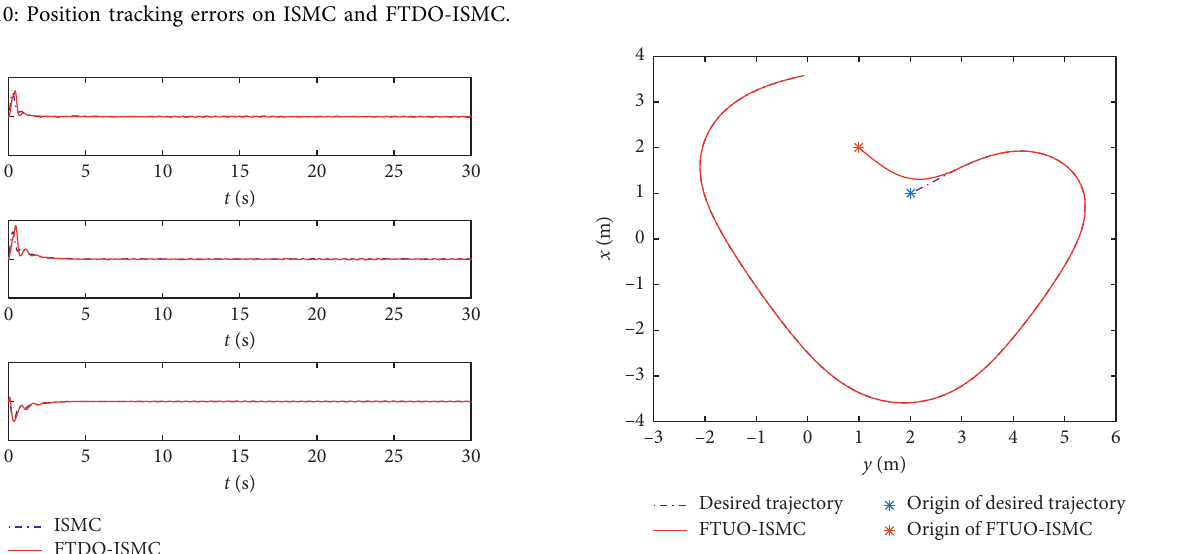
Figure 14: Planar trajectory tracking.